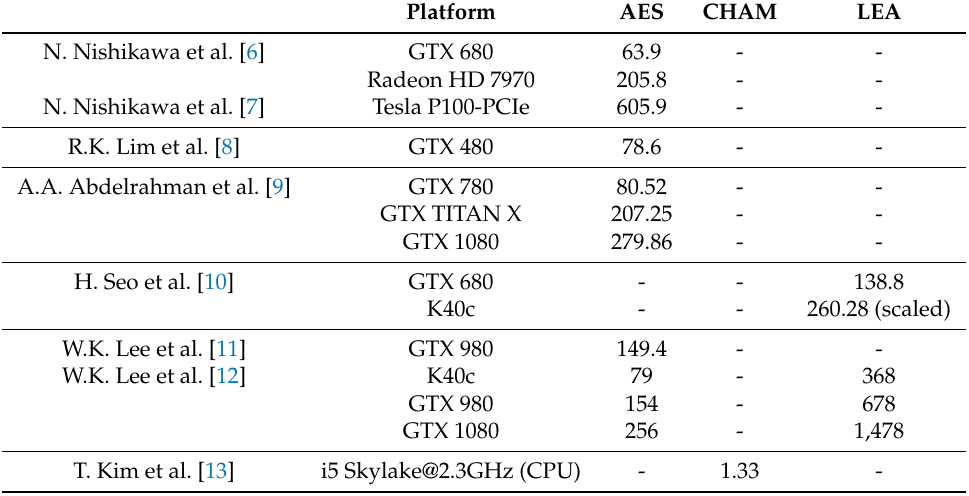
Table 1. Throughput (Gbps) table with existing implementation.